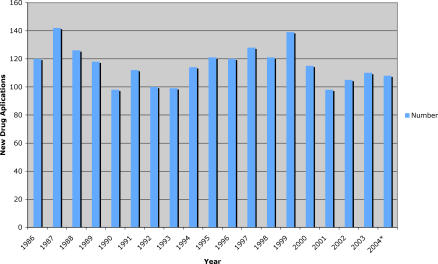
Applications for New Drug ApprovalsAsterisk indicates that new biologics applications were included in data for the first time. (Source: FDA, http://www.fda.gov/cder/rdmt/numofndareccy.htm)